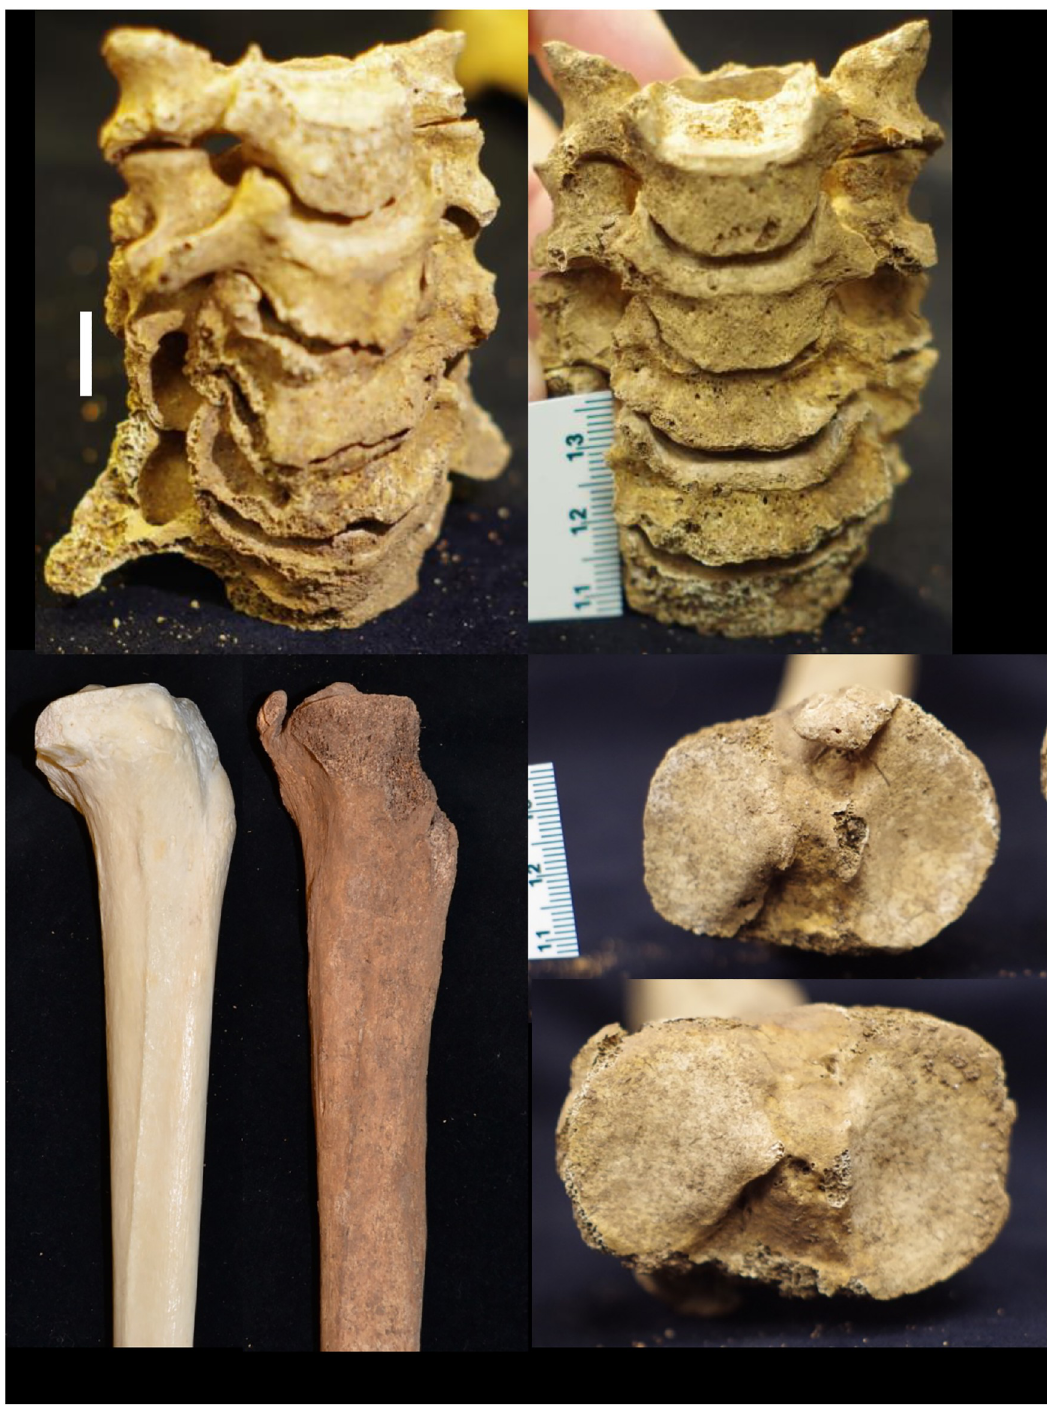
Fig 10. YNH4 postcranial pathologies. Top: YNH4 A (left) and B (right) cervical vertebrae enthesophytes. Bottom left: lateral view of YNH4 B proximal tibia (right) and a normal tibia (left). Bottom right: superior view of YNH4 B (top) and B2 (bottom) left proximal tibiae; See text for